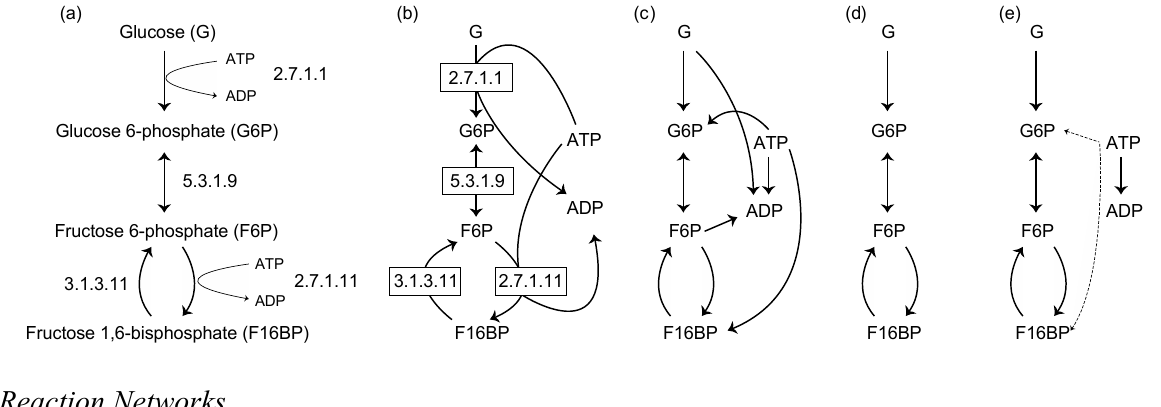
Figure 1. ( a ) A representation of a metabolic pathway as depicted in textbooks. ( b ) A representation using bipartite graphs. Examples of substrate–product networks based on chemical equations ( c ), based on chemical equations in which ubiquitous metabolites such as ATP and ADP are removed (d) , and based on atomic traces ( e ). The solid and dashed lines represent the traces based on carbon and phosphorus atoms,